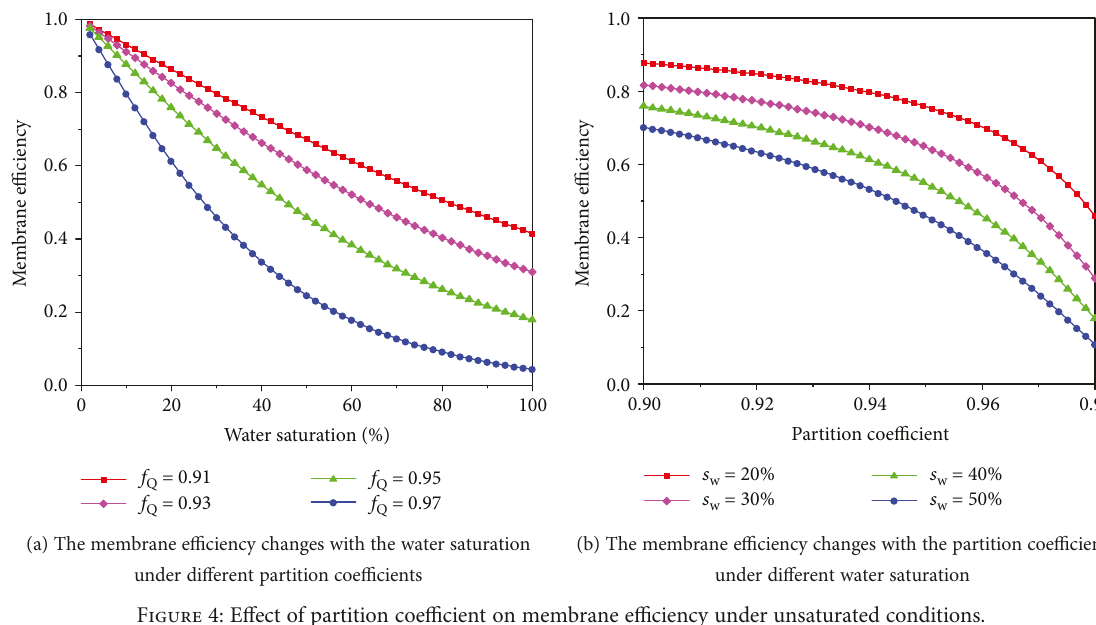
Figure 4: E ff ect of partition coe ffi cient on membrane e ffi ciency under unsaturated conditions.